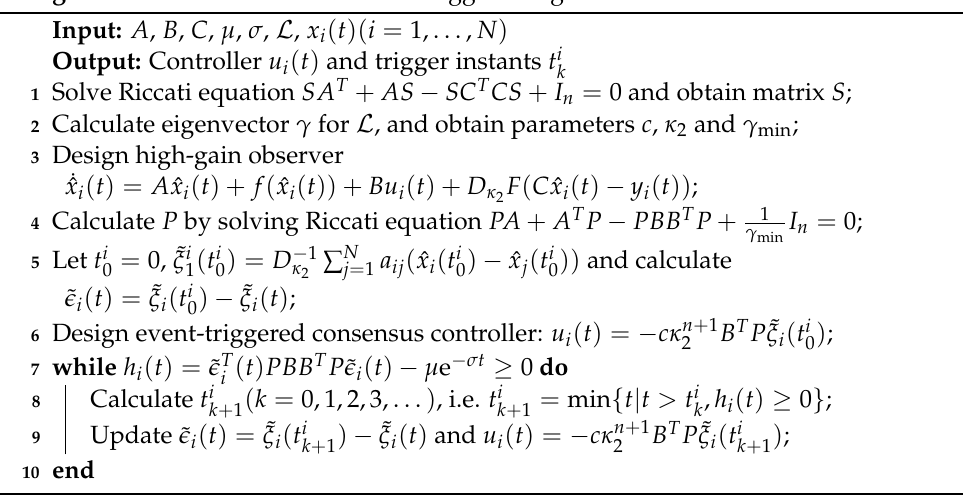
Algorithm 2: Observer-based event-triggered